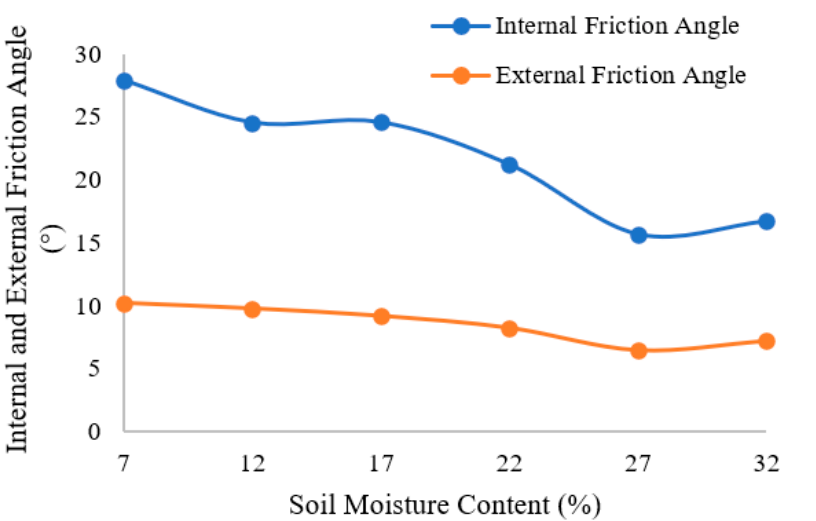
Figure 12. Cohesion/adhesion at different moisture contents.